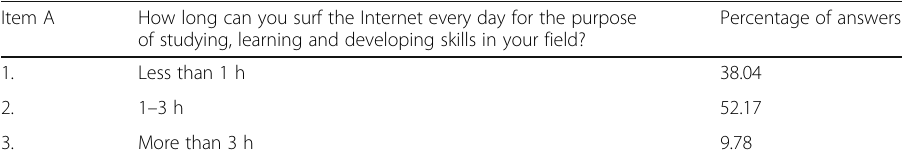
Table 3 The correlation between the four axes Correlations Pearson E-research Using mobile Knowing how Training and Correlation and e-lectures phones apps to use mobile skill development Sig. (2-tailed) phones apps E-research and e-lectures. 1 .485 ** .499 ** .612 ** 92 .000 .000 .000 92 92 92 92 Using mobile phones apps 92 .485 ** 1 .305 ** .446 ** .000 .003 .000 92 92 92 92 Knowing how to use mobile 92 .499 ** .305 ** 1 .736 ** phones apps. .000 .003 .000 92 92 92 92 Training and skill development 92 .612 ** .446 ** .736 ** 1 .000 .000 .000 92 92 92